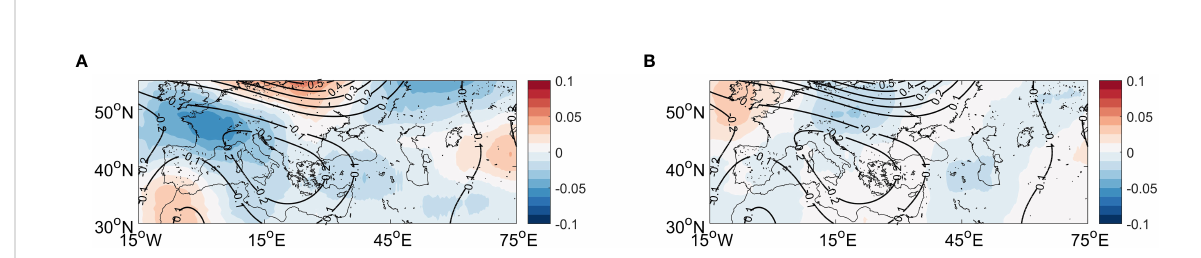
FIGURE 8 The lagged regressions of (A) Rossby wave-induced and (B) transient eddy-induced 500-hPa geopotential height tendency (shading; unit, gpm day − 1 ) in DJF onto the KEI 2 months earlier, superposed by the estimated response of 500-hPa geopotential height tendency (contours; unit,